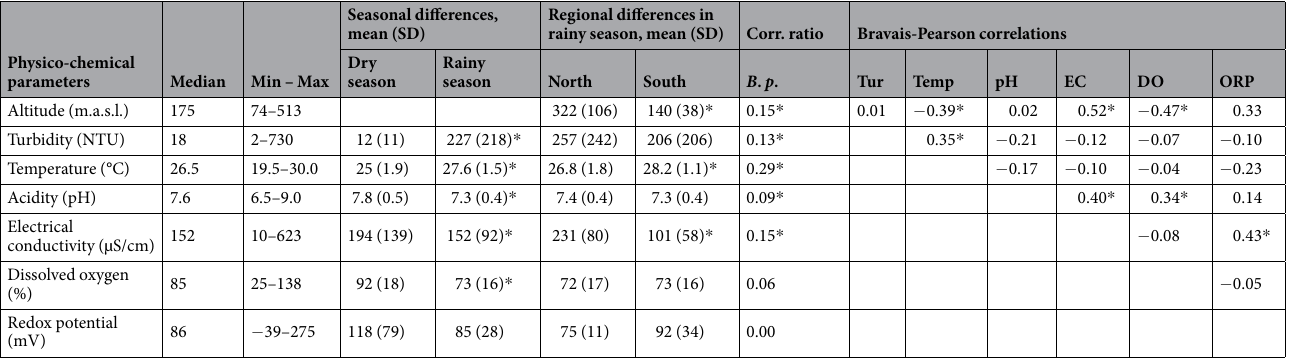
Table 3. Characteristics of physico-chemical water parameters and altitude. Abbreviations: m.a.s.l. = meters above mean sea level, NTU = nephelometric turbidity units, mean = arithmetic mean, SD = standard deviation, Corr. ratio = correlation ratio, B . p . = B . pseudomallei , Tur = turbidity, Temp = temperature, pH = acidity, EC = electrical conductivity (proxy for salinity), DO = dissolved oxygen, ORP = redox potential. N = 67; exceptions: turbidity (n = 66), median, minimum and maximum of altitude in the rainy season (n = 31). The Bravais-Pearson correlation coefficient (r) is given for directional correlations between physico-chemical parameters, the correlation ratio ( η 2 ) for undirectional correlations between the presence of B . pseudomallei and physico-chemical parameters, range from 0 (no correlation) to 1 (perfect correlation). Statistical tests: seasonal comparison: paired t-test (n = 31 pairs, for turbidity n = 30 pairs), regional comparison: t-test, correlation